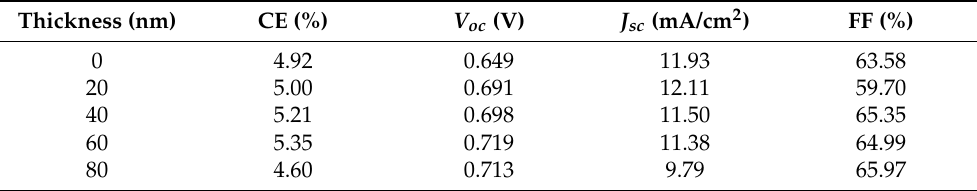
Figure 6. Dye-sensitized solar cells (DSSCs) ( a ) without and ( b ) with the RF-PECVD DLC anti- reflective coatings (ARCs). ( c ) Cell characteristics ( J - V curves) of the DSSCs with different thickness of the RF-PECVD DLC ARC compared with the non-ARC cell. Table 1. Optoelectronic properties of the DSSCs with different thickness of the RF-PECVD DLC ARC compared with the non-ARC cell.